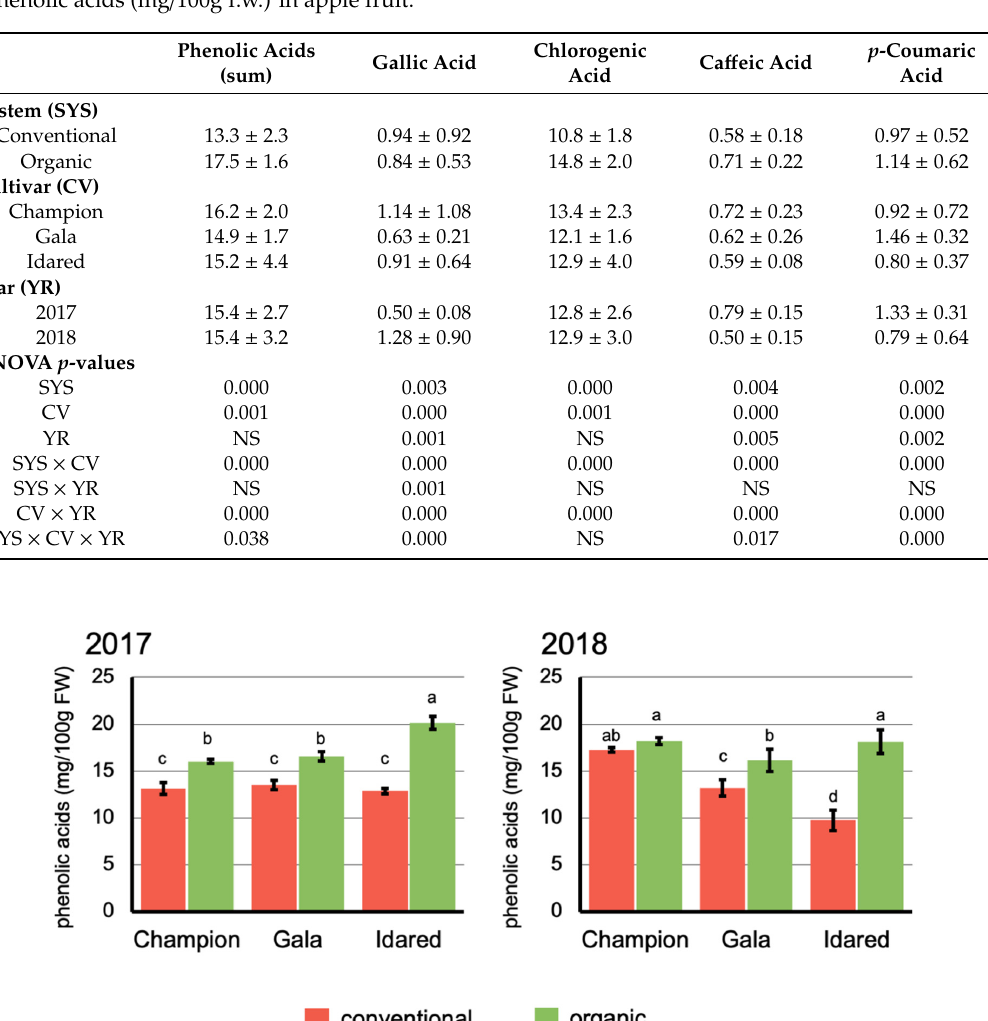
Table 2. The main e ff ect of (and interaction between) the production system (conventional and organic), cultivar (Champion, Gala, Idared) and harvest year (2017, 2018) on the concentrations (mean ± SD) of phenolic acids (mg / 100g f.w.) in apple fruit.